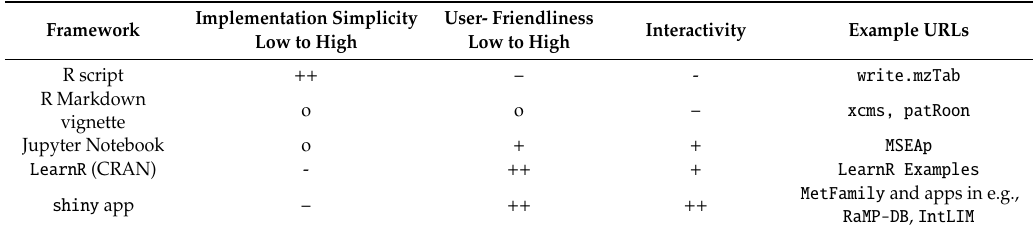
Table 10. Categorisation of creatingand sharing R code and data analysis functionality. Symbols indicate strengths ( + , ++ ) or weaknesses (-, –) or neutral (o)